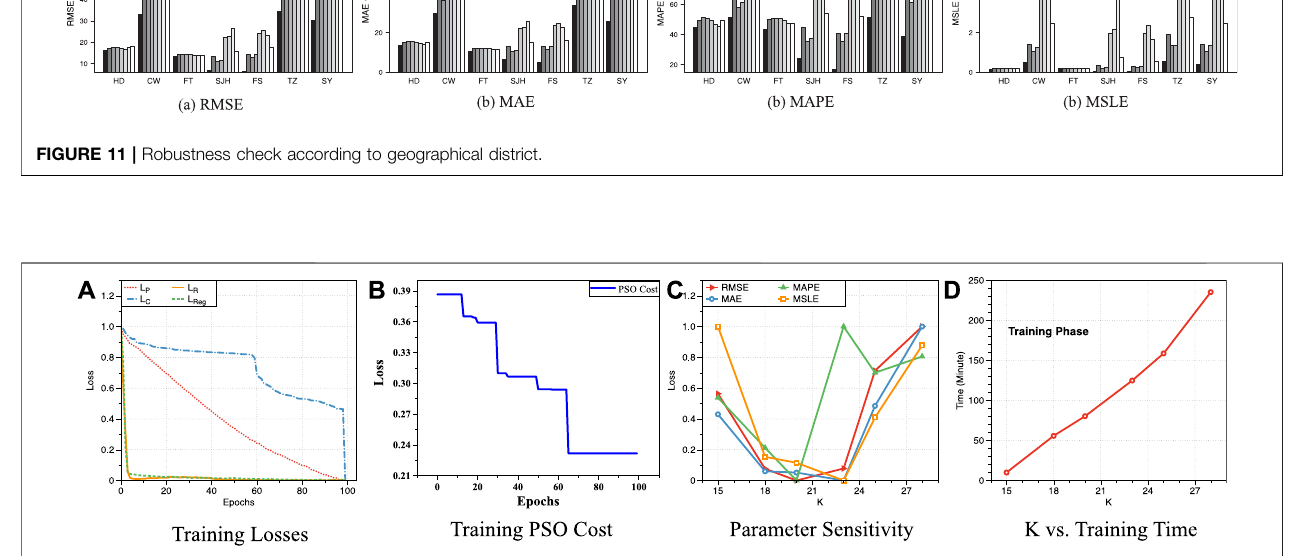
FIGURE 12 | Study the stability and sensitivity of AutoFTP. (A) Training Losses. (B) Training PSO Cost. (C) Parameter Sensitivity. (D) K vs. Training Time.